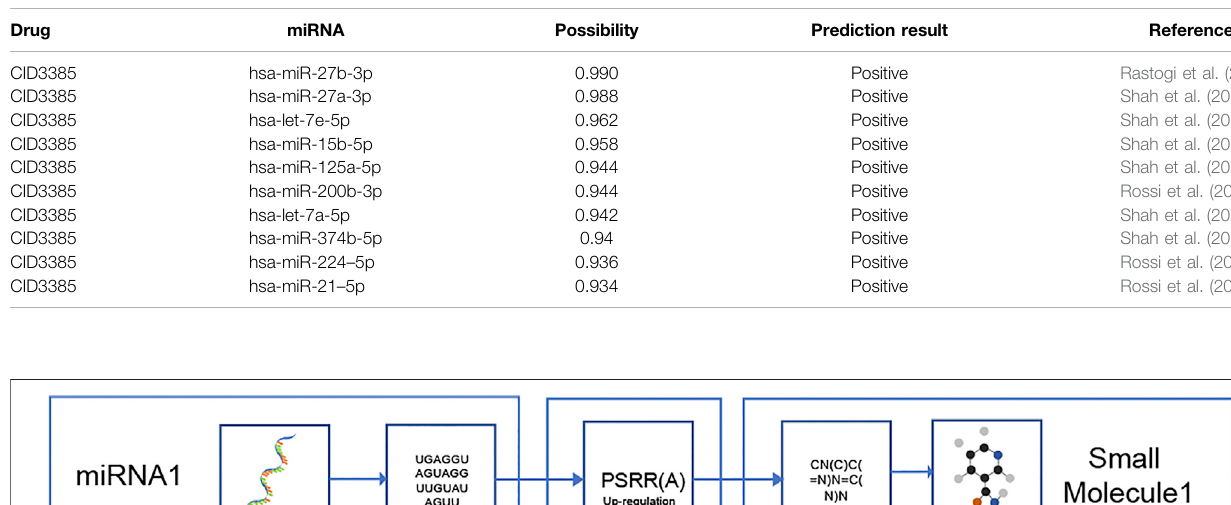
TABLE 3 | Top 10 predicted miRNAs with highest probabilities are found to be experimentally decreased by CID3385.